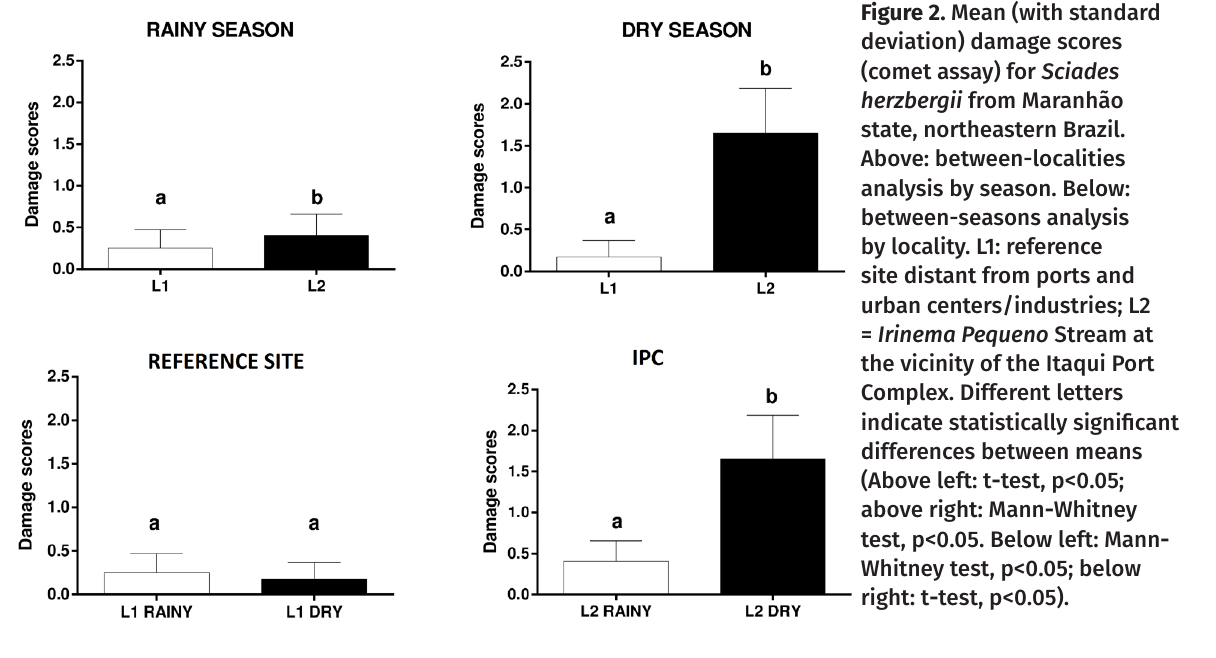
Figure 2. Mean (with standard deviation) damage scores (comet assay) for Sciades herzbergii from Maranhão state, northeastern